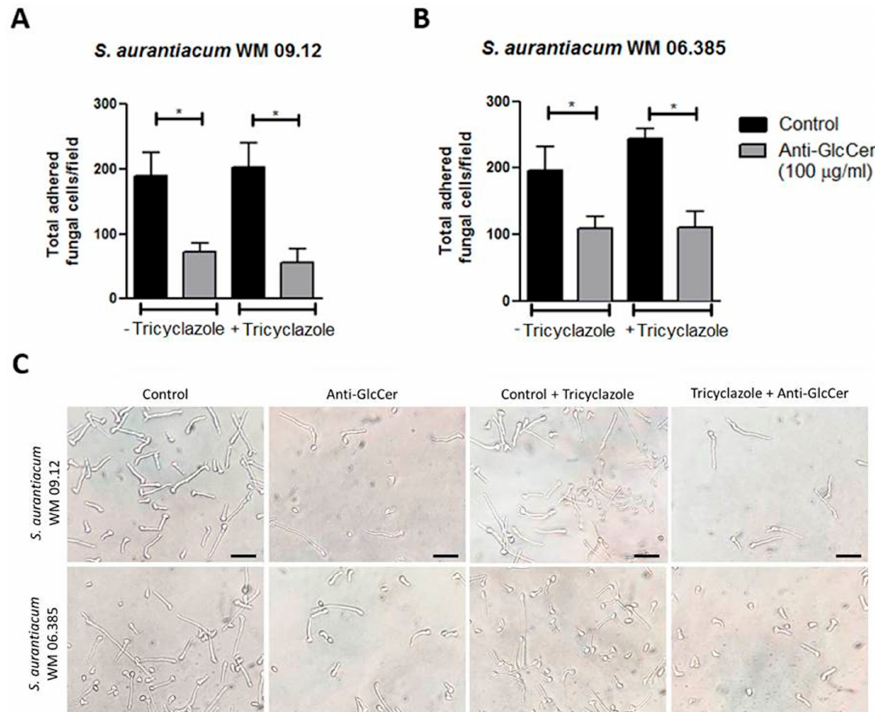
Figure 7. Adhesion of germinated conidia from S. aurantiacum to polystyrene after 6 h incubation with anti-GlcCer (100 µg/mL). Total adhered cells of S. aurantiacum WM 09.12 ( A ) and WM 06.385 ( B ) were counted in an inverted microscope. ( C ) Representative images of adhered fungal cells to polystyrene. Conidia were cultivated in the absence ( − ) or presence (+) of tricyclazole (16 µg/mL). * p < 0.01. Scale bar: 10 µm.